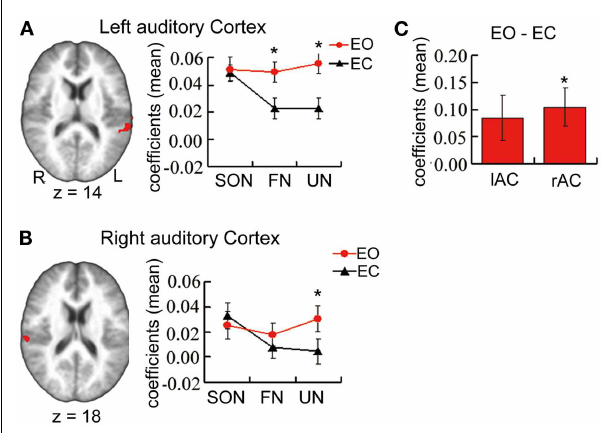
FIGURE 1 | (A,B) From Experiment 1 main part. ROI’s showing a significant interaction effect in a 3 × 2 ANOVA of estimated coefficients for name condition (SON, FN, UN) and baseline (EO, EC) in bilateral auditory cortex. Graphs show estimated coefficients (mean across region ± SE) for name conditions relative to baselines. (C) From Experiment 2. Estimated coefficients of the contrast [EO – EC] in the same ROIs. r/lAC = right/left auditory cortex. *Significant difference.